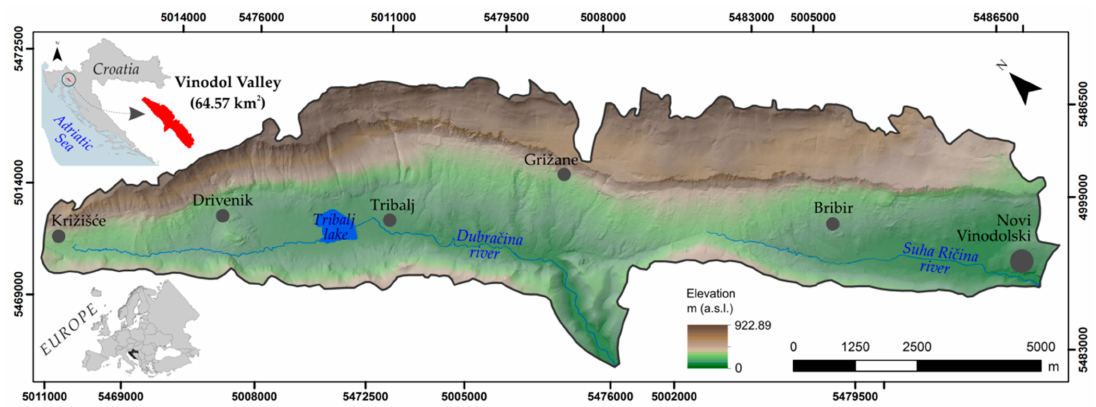
Figure 1. Geographical location and the relief map of the Vinodol